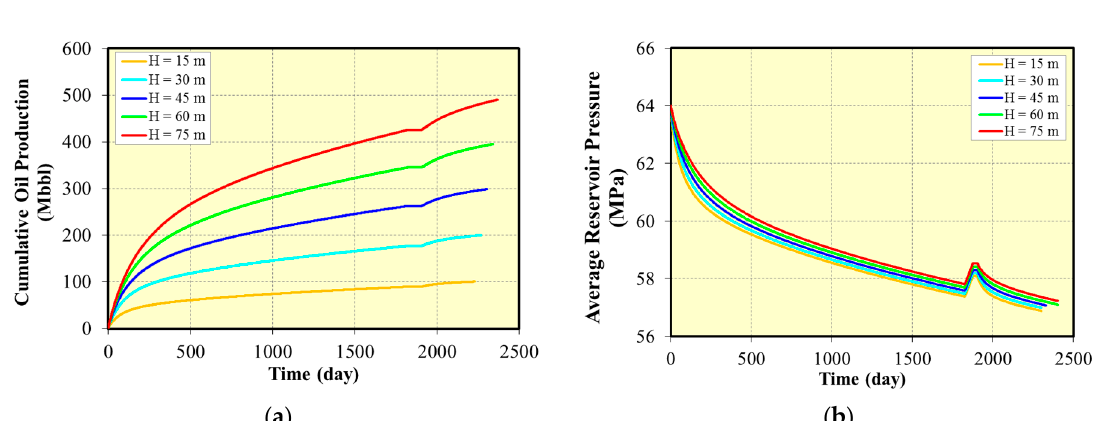
Figure 4. Effect of different reservoir thickness with one huff-n-puff cycle on oil production and reservoir pressure: ( a ) Cumulative oil production for different reservoir thickness; ( b ) Average reservoir pressure for different reservoir thickness.